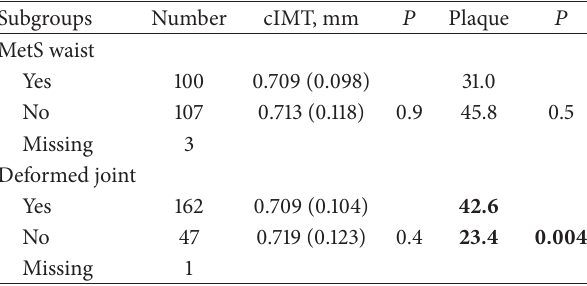
Table 5: Carotid atherosclerosis in RA patients by abdominal obesity and clinical joint damage